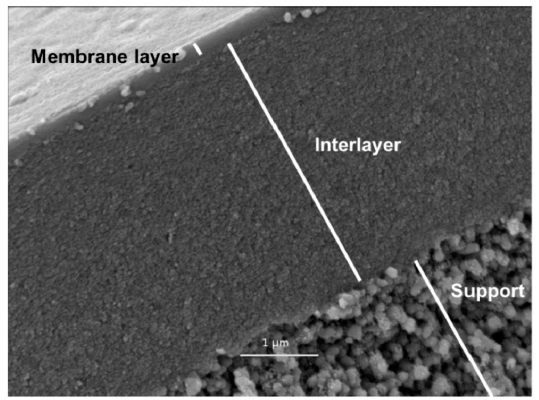
Figure 4. SEM micrograph of the cross-section of a ceramic asymmetric membrane structure—Reproduced by permission of The Royal Society of Chemistry [48] The membrane top layer is made of cobalt silica film with thickness of 250 nm, the interlayer is alumina with thickness of 3.5–4 mm and the bottom and substrate is coarser